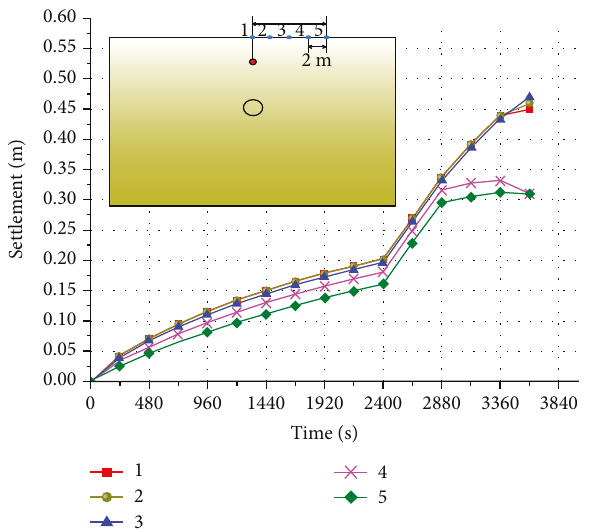
Figure 23: Surface subsidence